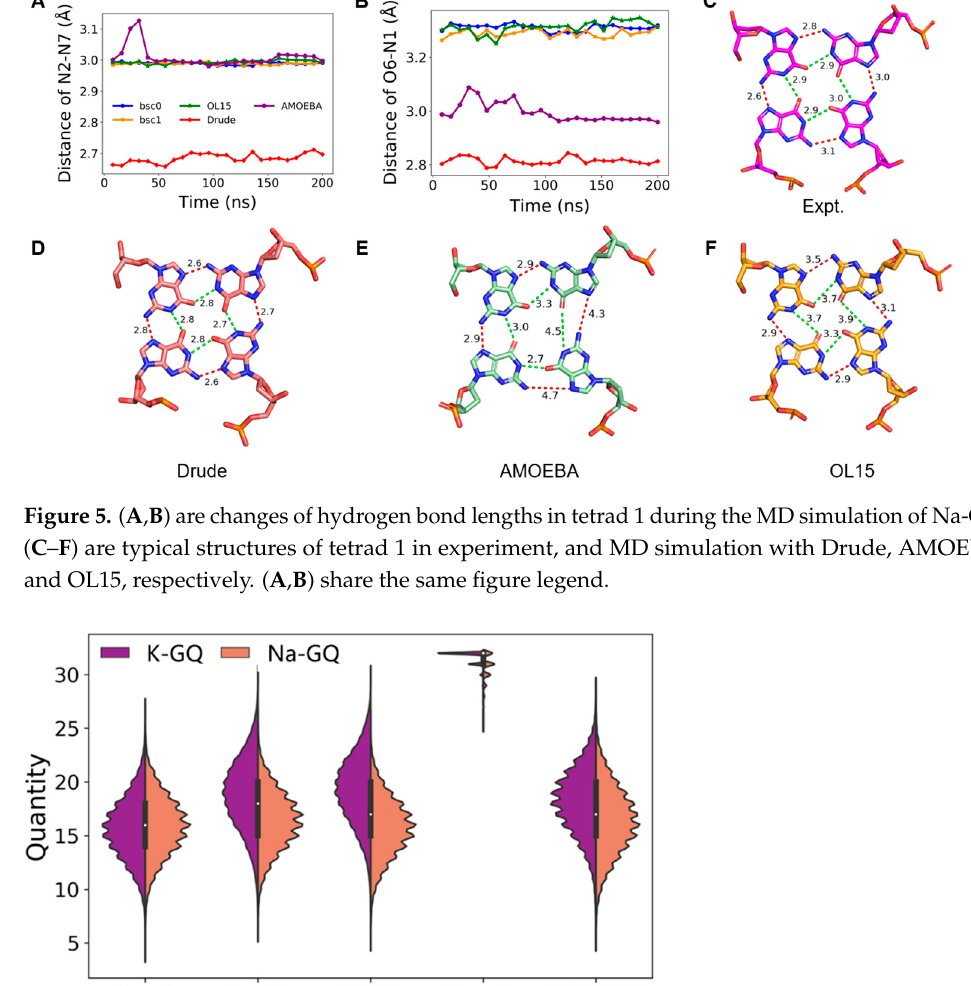
Figure 4. ( A ) and ( B ) are changes of hydrogen bond lengths in tetrad 1 during the MD simulation of K ‐ GQ. ( C )–( F ) are typical structures of tetrad 1 in experiment, and MD simulation with Drude, AMOEBA, and OL15, respectively. ( A ) and ( B ) share the same figure legend.